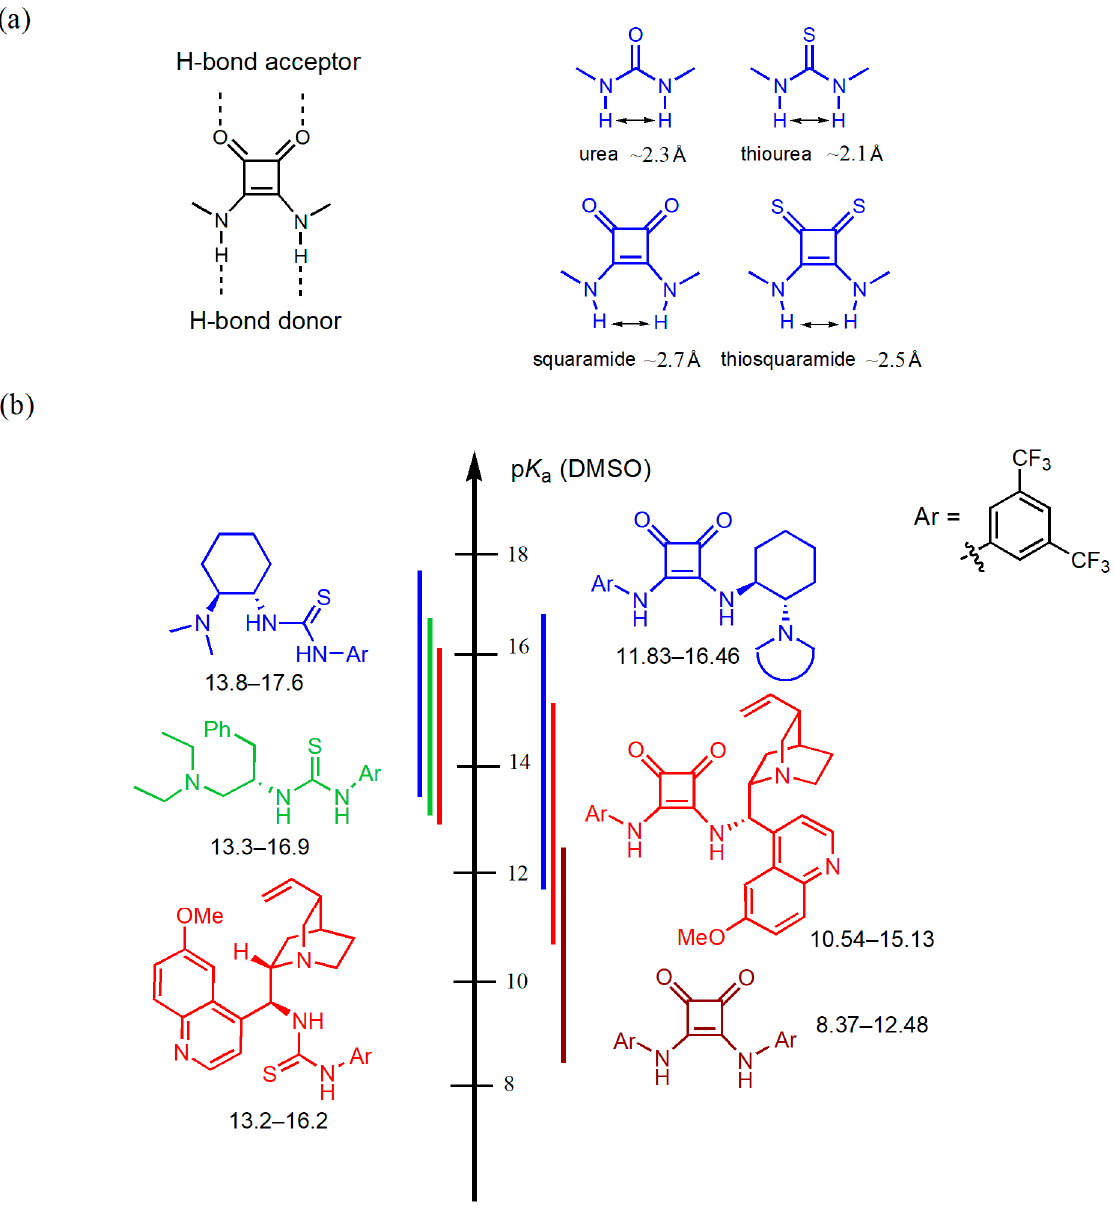
Figure 1. ( a ) Duality in hydrogen bonding in squaramides and H-bond spacing distances in H-bond donor catalysts and ( b ) the p K a value acidity scales of typical thiourea and squaramide-based catalysts [7,8].